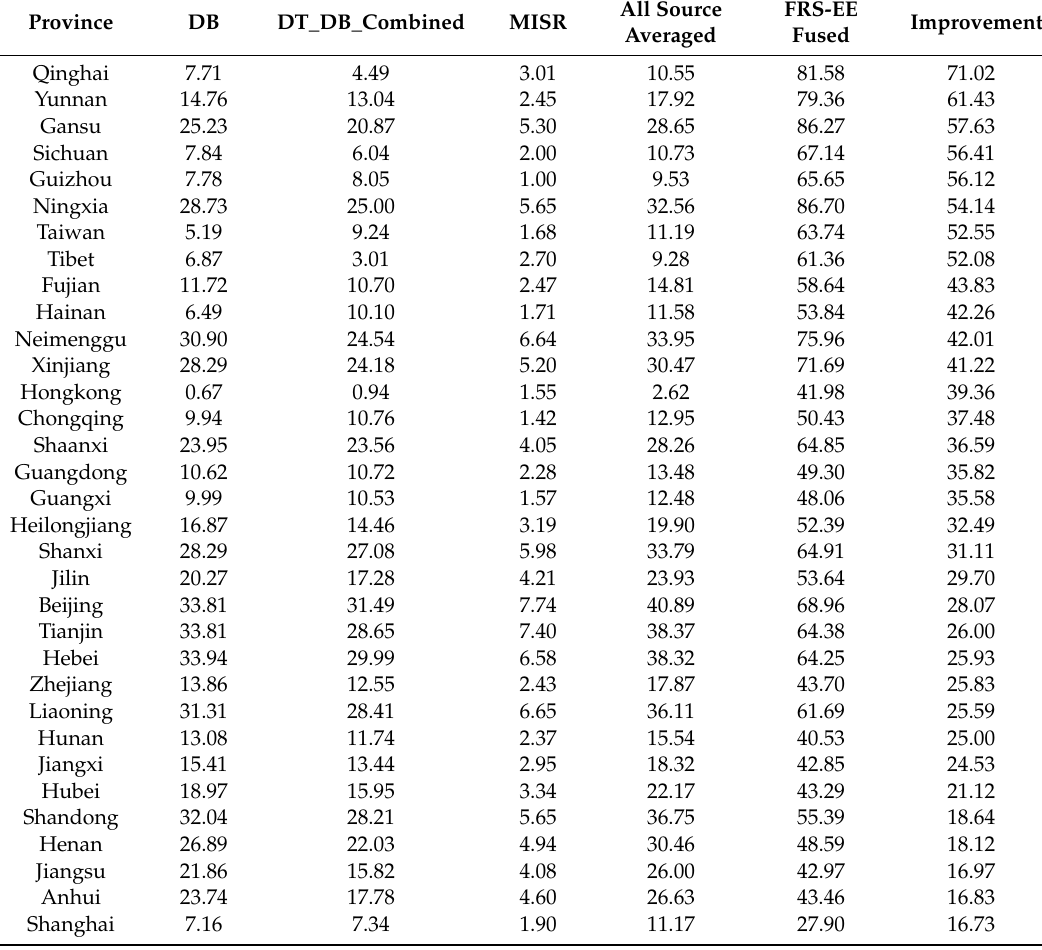
Table 3. The average of temporal completeness for original, all source averaged, and FRS-EE fused AODs in different provinces.